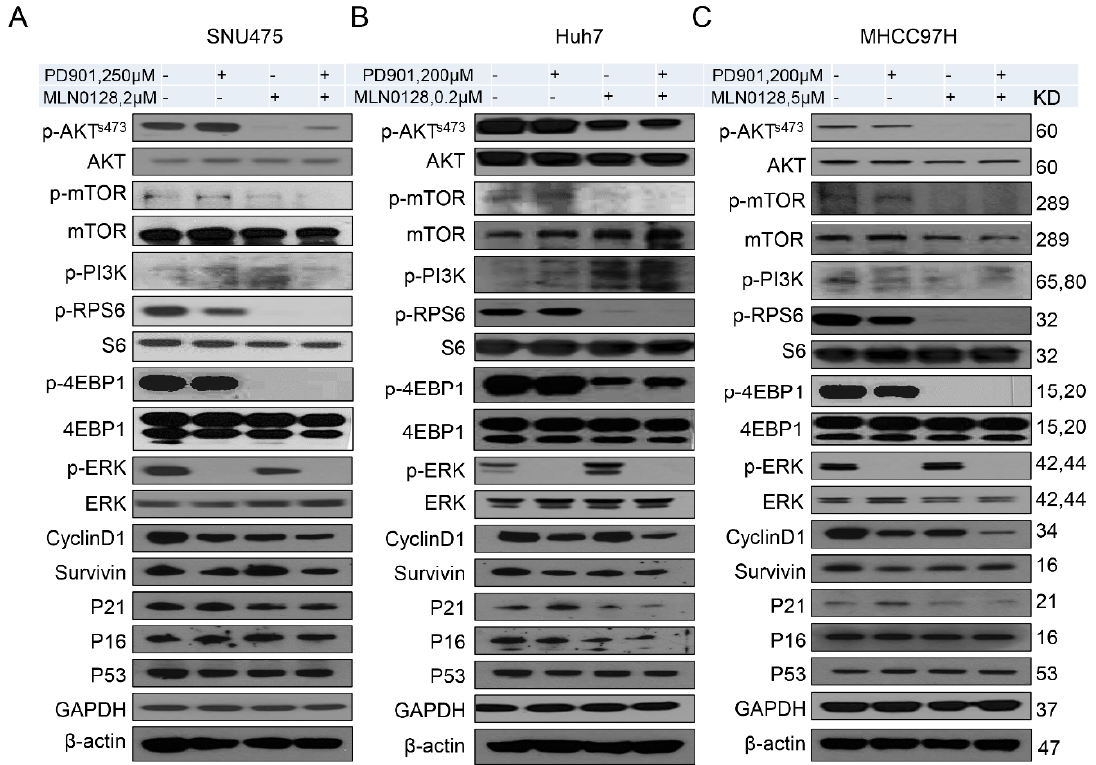
Figure 4. E ff ect of combined PD901 / MLN0128 treatment on the levels of putative targets in HCC Figure 4. Effect of combined PD901/MLN0128 treatment on the levels of putative targets in HCC cell cell lines. ( A – C ) Representative western blot analysis of AKT / mTOR, Ras / MAPK, and proliferation lines . ( A – C ) Representative western blot analysis of AKT/mTOR, Ras/MAPK, and proliferation signaling pathways in SNU475 ( A ), Huh7 ( B ), and MHCC97H ( C ) HCC cell signaling pathways in SNU475 ( A ), Huh7 ( B ), and MHCC97H ( C ) HCC cell lines.